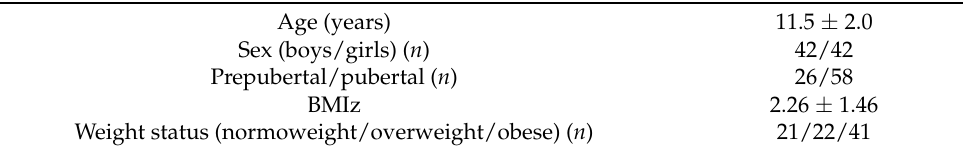
Table 1. Participant characteristics (mean ± SD or n